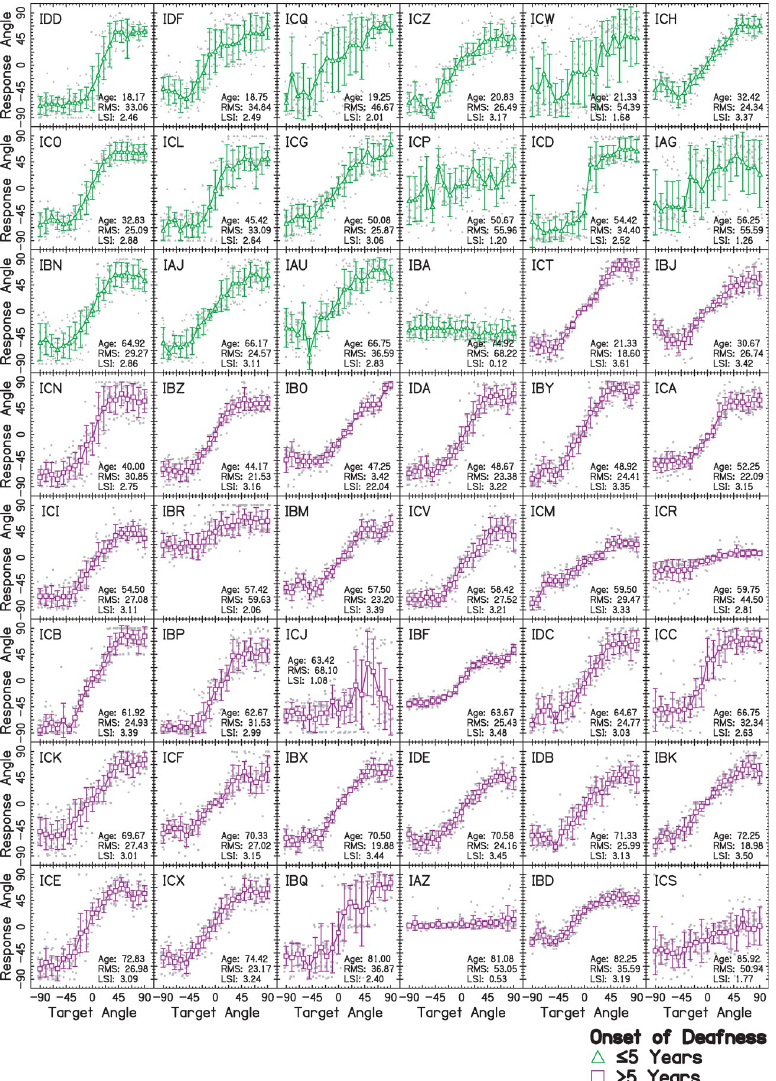
Fig 3. Sound source localization for forty-eight listeners with BiCIs. The x-axis shows the angle from which the target speaker presented pink noise bursts. The y-axis shows the angle from which the listener perceived the sound to be presented. Each panel shows a different listener whose subject codes are given in the top-left corner. Mean ± 1 standard deviation for listeners who experienced an onset of deafness either � 5 years or > 5 years are shown with green 4 and magenta ▢ symbols, respectively. Individual responses are shown jittered in gray in the background. Within each group, listeners are arranged by increasing age at testing, which is given in years as “Age” in years within each panel. Additionally, the RMS error over all target angles and LSI are listed in the bottom-right of each panel.